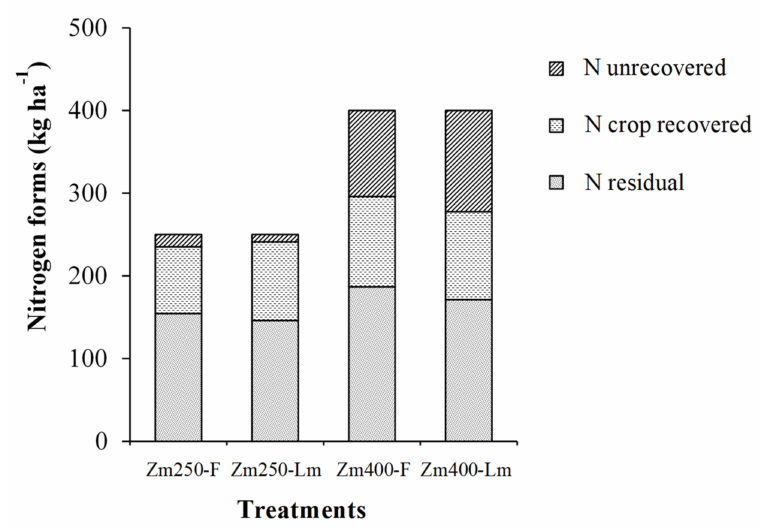
Figure 3. Final forms of nitrogen (N) recovered in the crop, residual on the soil, or unrecovered at the end of the maize growing season.